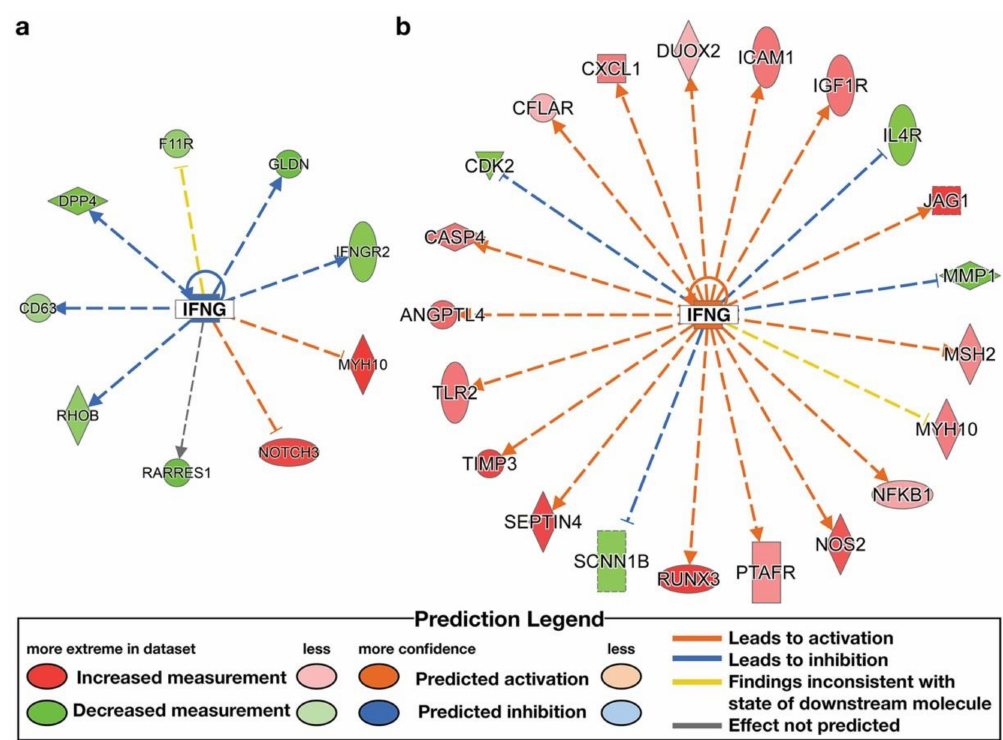
Figure 6. Differentially expressed genes (FDR adjusted p -value < 0.05) contributing to the identifi- cation of the upstream regulator, interferon gamma (IFNG), following lignan flaxseed intervention: ( a ) predicted inhibition of IFNG in high-ENL excreters (z-score − 2.094); ( b ) predicted activation of IFNG in low-ENL excreters (z-score 3.343). The full network of genes contributing to activation